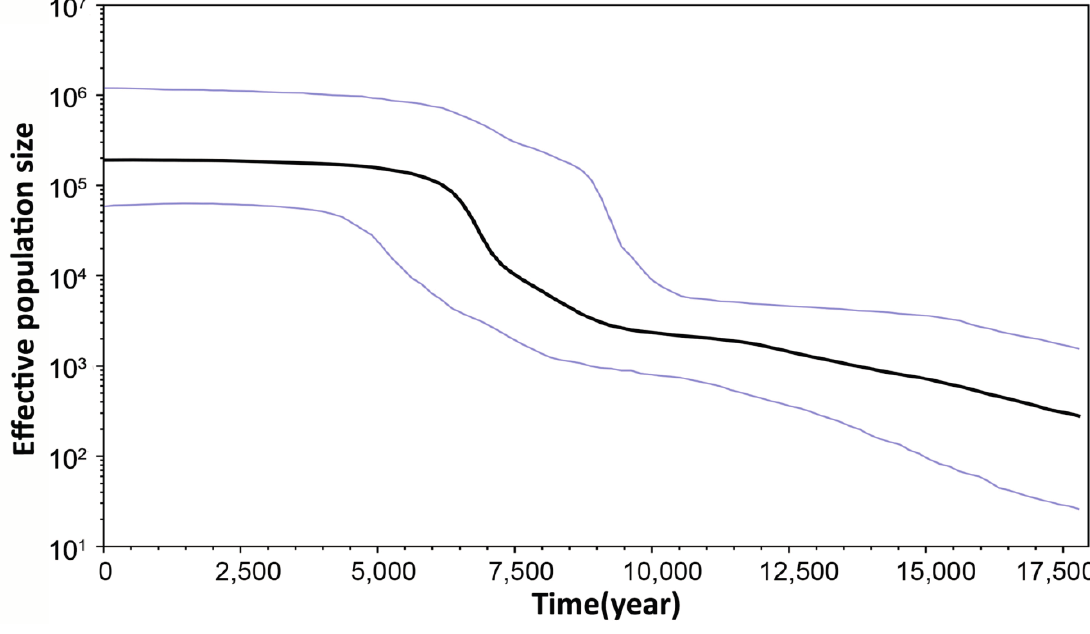
Figure 2. Bayesian skyline plots of the effective sizes through time for Cirrhimuraena chinensis Kaup based on concatenated sequences (cyt b + CR). The upper and lower limits of the light blue trend represent the 95% confidence intervals of highest posterior densities (HPD)